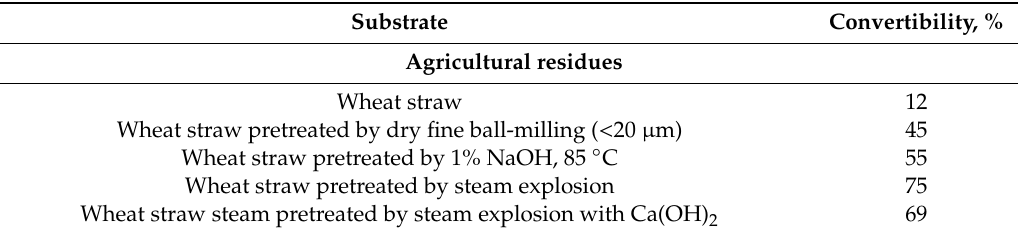
Table 2. Convertibility of di ff erent cellulose-containing materials in hydrolysis by a mixture